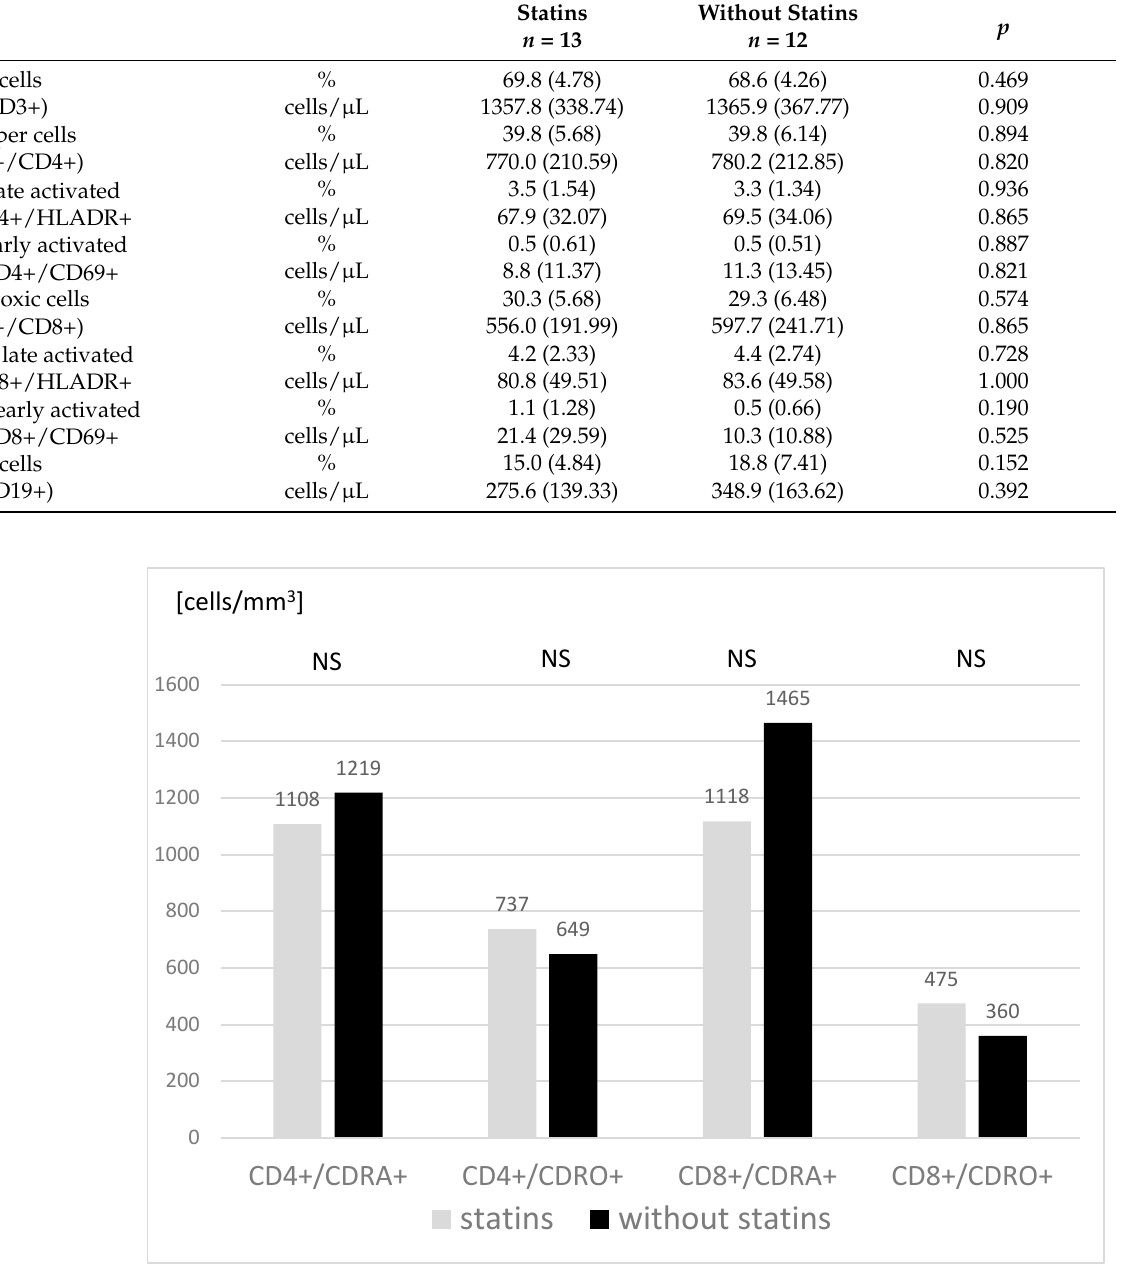
Figure 3. Expression of RA and RO maturation markers on T lymphocytes in studied subjects. Treated with simvastatin n = 11, not treated with simvastatin n = 12. Mann–Whitney two-sided rank U-test was used. NS: not significant. Table 3. Main subpopulations of peripheral blood lymphocytes in studied participants. The data are presented as a percentage of receptor-bearing cells and the absolute cell numbers. Mean values and standard deviations (in brackets) are shown. Mann–Whitney two-sided rank U-test was used.